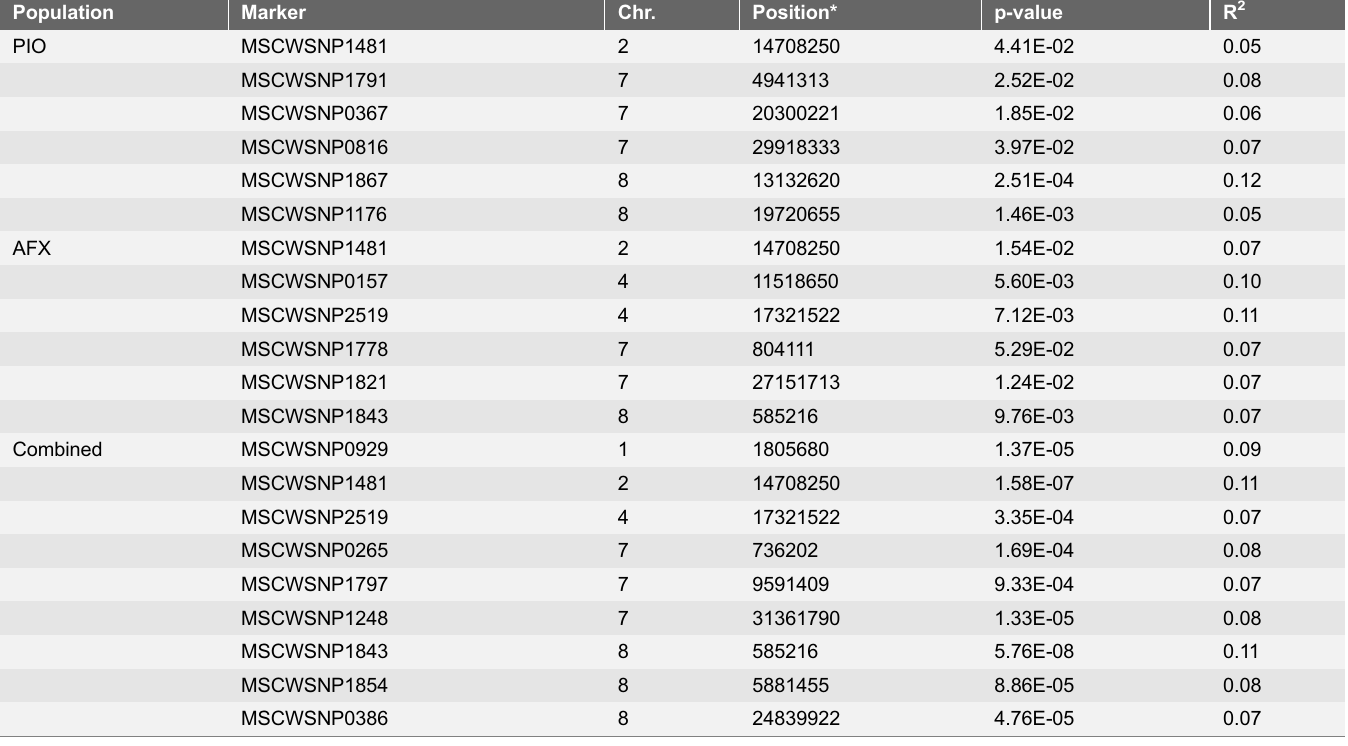
Table 4. Most significant SNP markers associated with Verticillium wilt resistance in the PIO, AFX and combined populations.